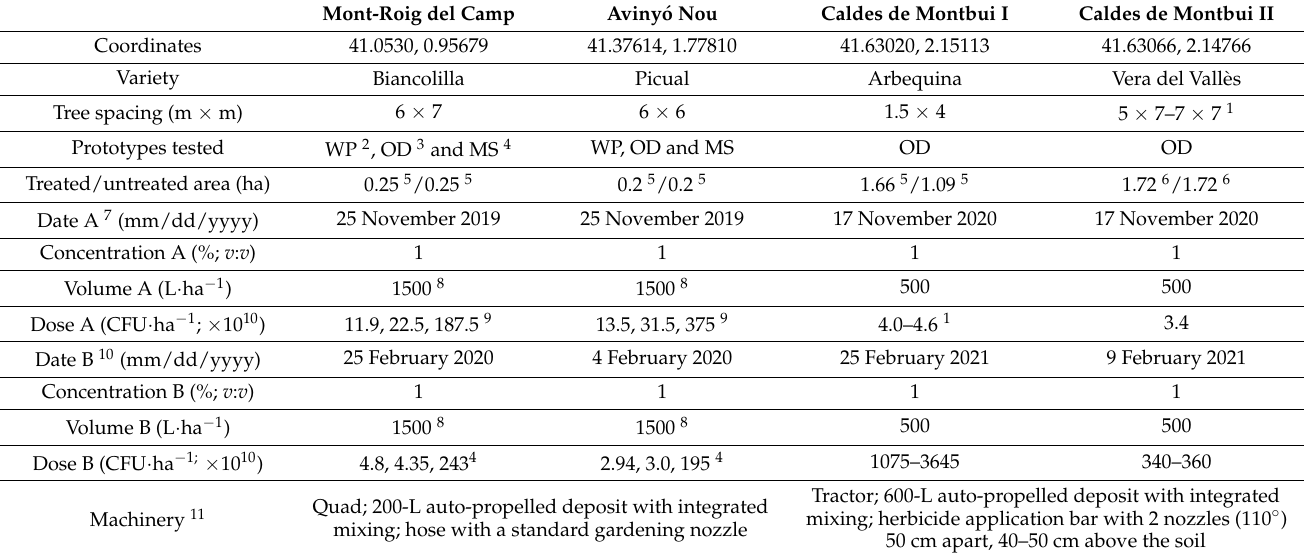
Table 1. Main features of field